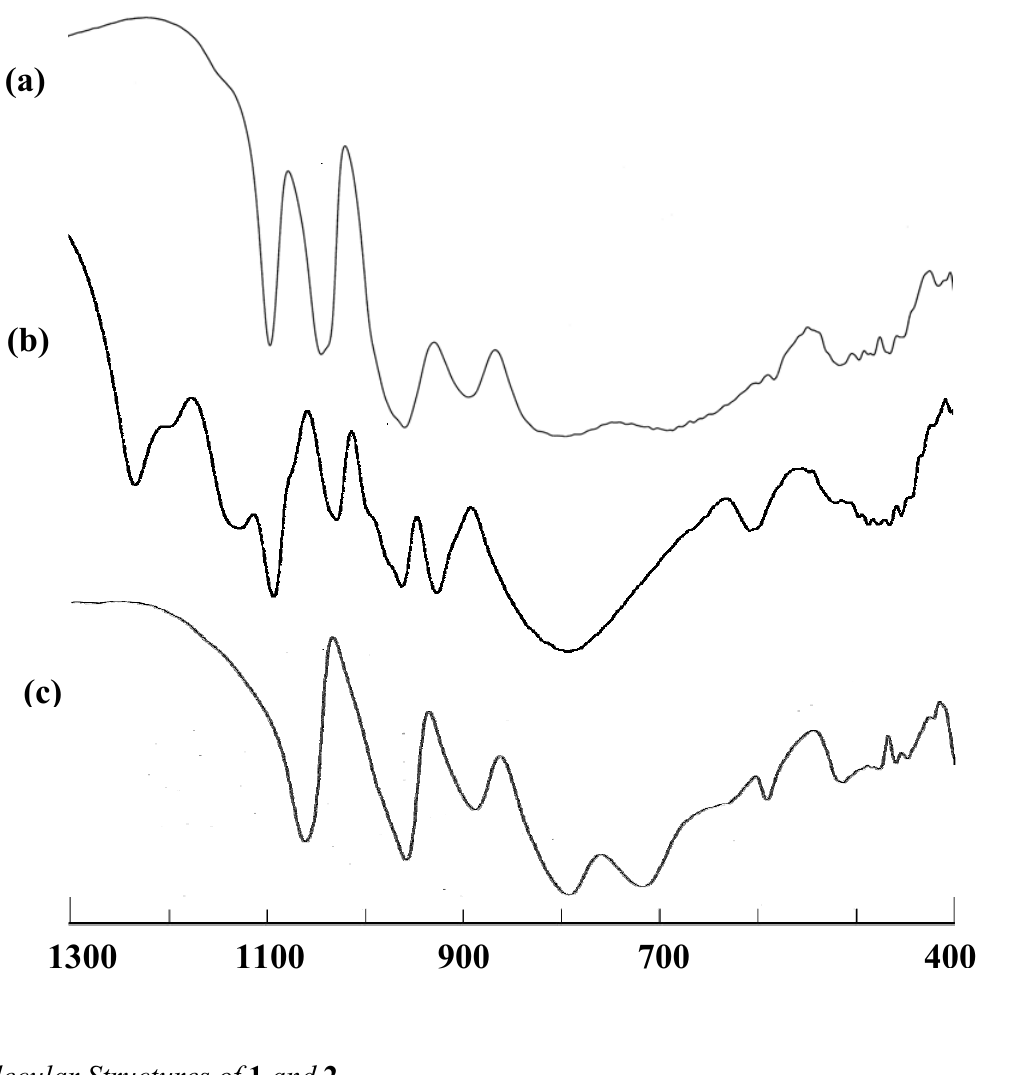
Ti O )] ·9H O ( K-1 ), (b) K [{Ti ( μ -O) (SO ) (H O) }( α - 9 2 38 2 2 3 4 3 4 2 2 8 H [( α -1,2,3-PW Ti O ) O ]·15H O as a 10 2 9 3 37 2 3 2